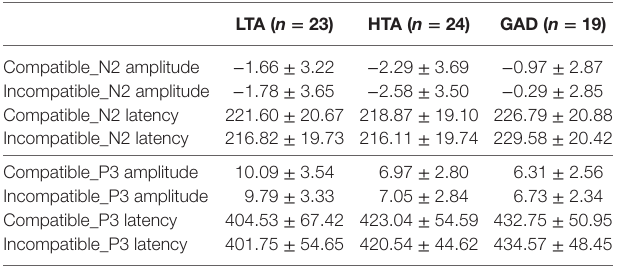
TaBle 3 | Amplitude (microvolts) and latency (milliseconds) of event-related potential components in emotional Flanker task (mean ± SD).